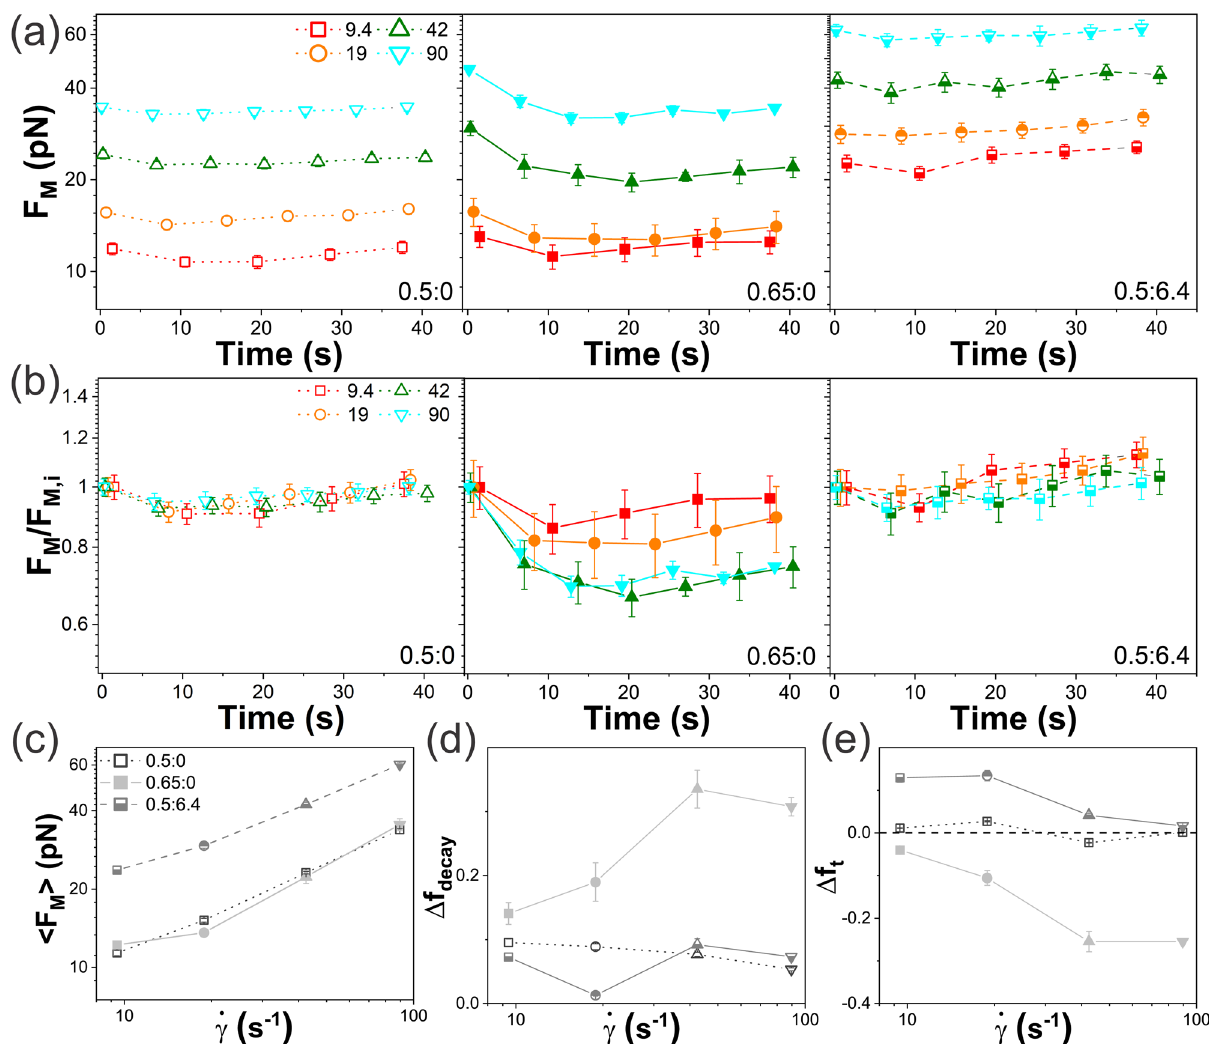
Fig.6|Cyclicforceresponsemonotonicallyincreaseswith _ γ andisstrongestin thepresence ofmicrotubules.a Maximum force F M reached during each cycle of repeated nonlinear straining (see Fig. 1) versus measurement time for _ γ = 9.4s − 1 (red), 19s − 1 (orange), 42s − 1 (olive), and 90 s − 1 (cyan) are shown for 0.5:0 (left, open symbols), 0.65:0 (middle, fi lled symbols), and 0.5:6.4 (right, half- fi lledsymbols). b Datashownin a ,normalizedbythecorrespondinginitial force F M , i , shows that F M for 0.65:0 (middle) decreases with subsequent cycling in a _ γ -dependent manner while F M increases for 0.5:6.4 (right). c F M